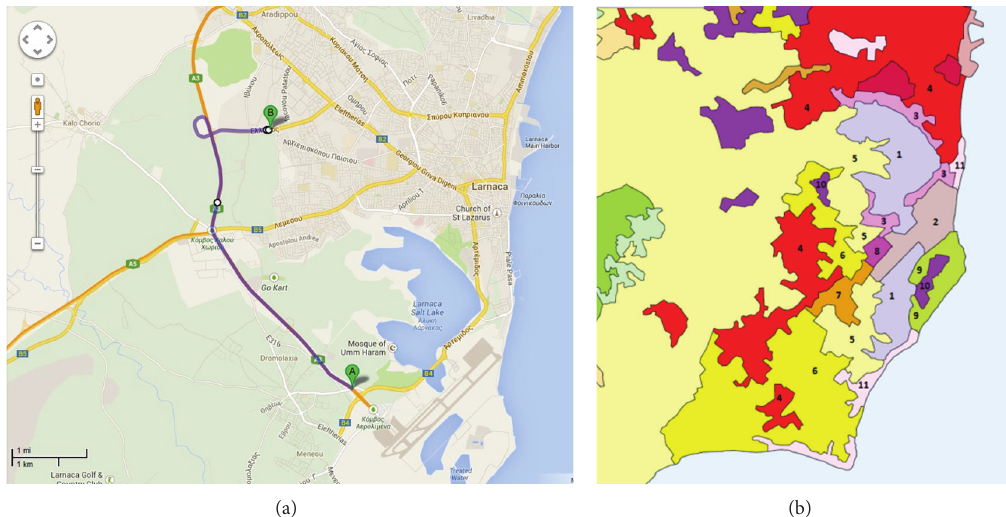
Figure 1: Sampling points in highway (points A and B) and land use around the collected point (1: saltmarsh, 2: airport, 3: small forest in urban area, 4: technical urban area, 5: agricultural areas without irrigation systems, 6: agricultural areas with intensive cultivation and irrigation system, 7: growing fruit cultivations with irrigation, 8: international airport, 9: areas with natural undergrowth, 10: industrial/livestock areas, and 11: athletic areas, beaches) (Google